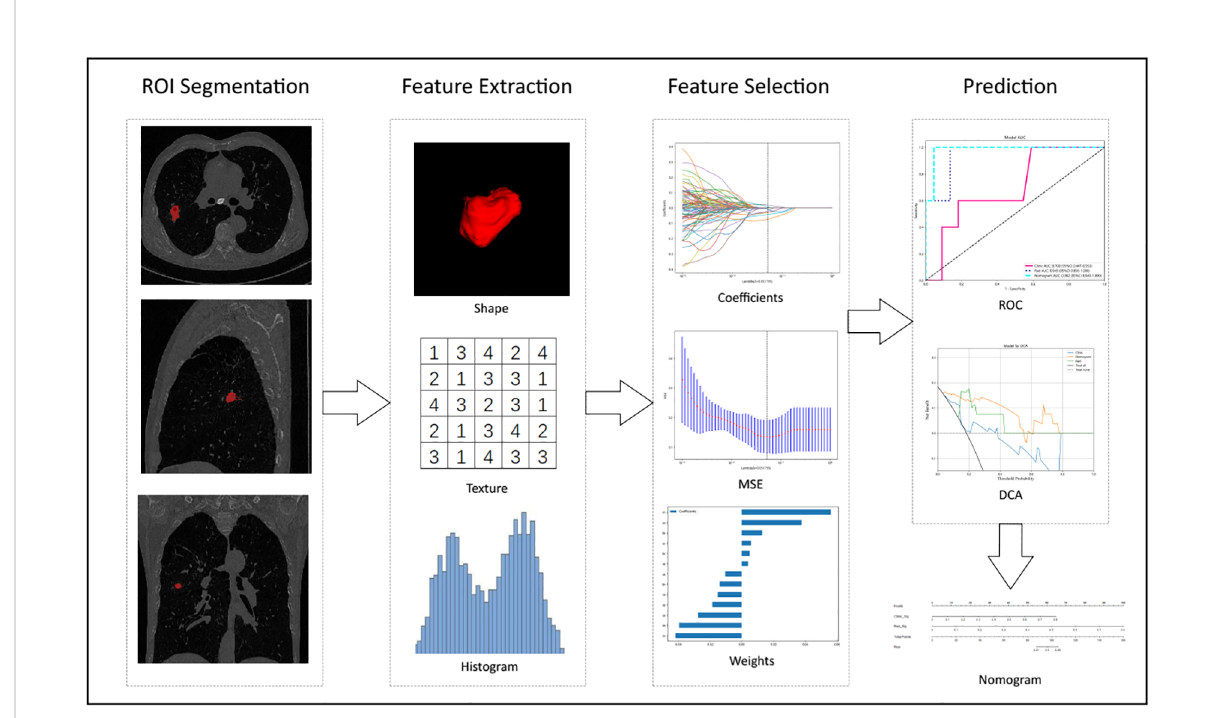
FIGURE 2 Work fl ow of radiomic analysis in this study. Nodules were segmented by radiologists, and features were extracted and selected by LASSO based on which the prediction model, DCA, Decision curve analysis, and nomogram were